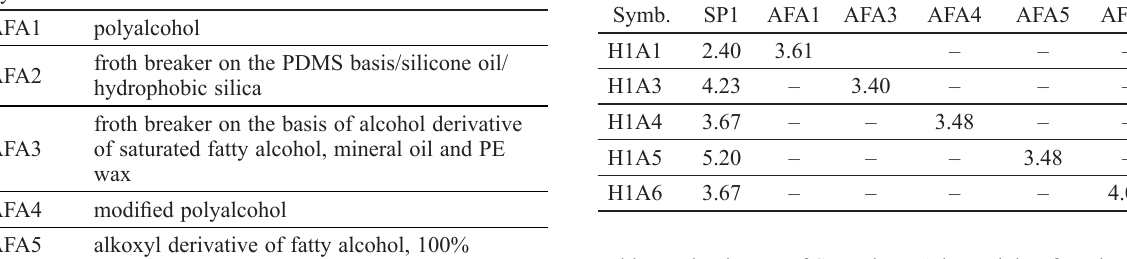
Table 7. The dosage of SP and VMA by weight of total binder, %